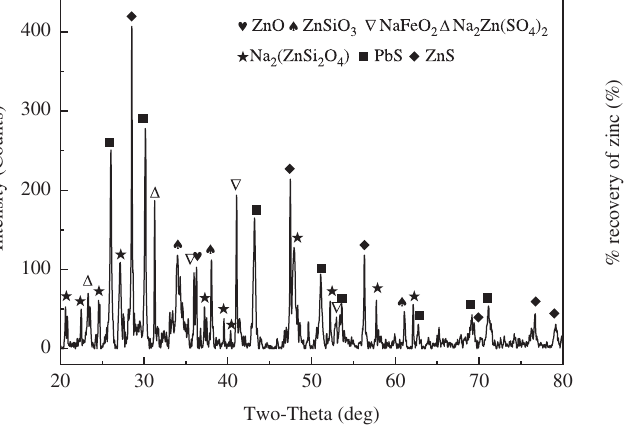
Figure 5: Zinc leaching rate of zinc sulfide